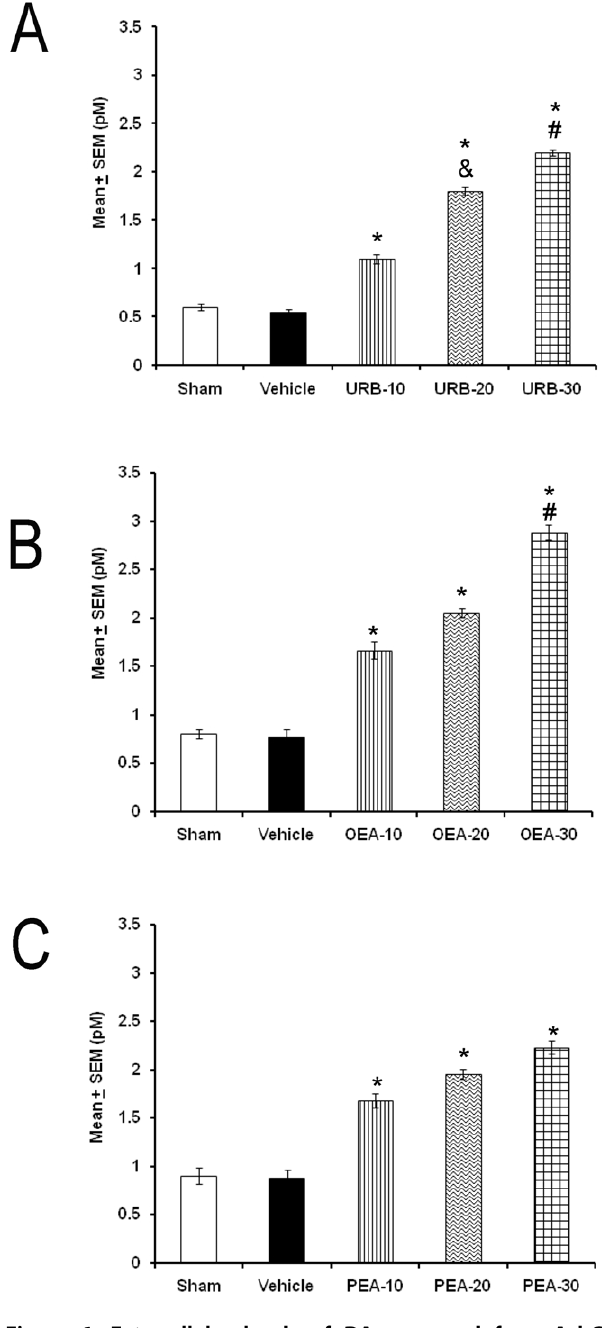
Figure 6. Extracellular levels of DA measured from AcbC during 3 h after the administration into lateral hypothalamus of URB597, OEA or PEA (10, 20, 30 m g/1 m L; each compound). Each point represents Mean 6 SEM of pM (* vs. Sham/Vehicle, p , 0.05; # vs. respective compound at 10/20 m g/1 m L, p , 0.05; & vs. respective compound at 10 or 20 m g/1 m L, p ,